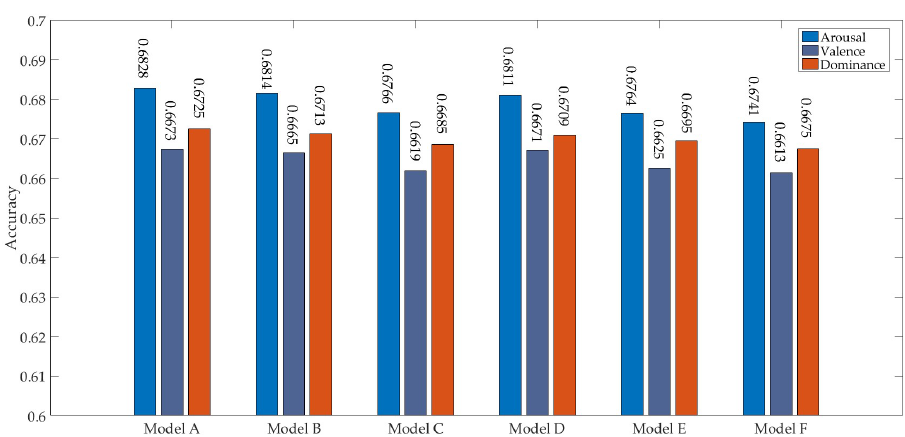
Figure 8. Accuracy of different models in three dimensions in the second step.